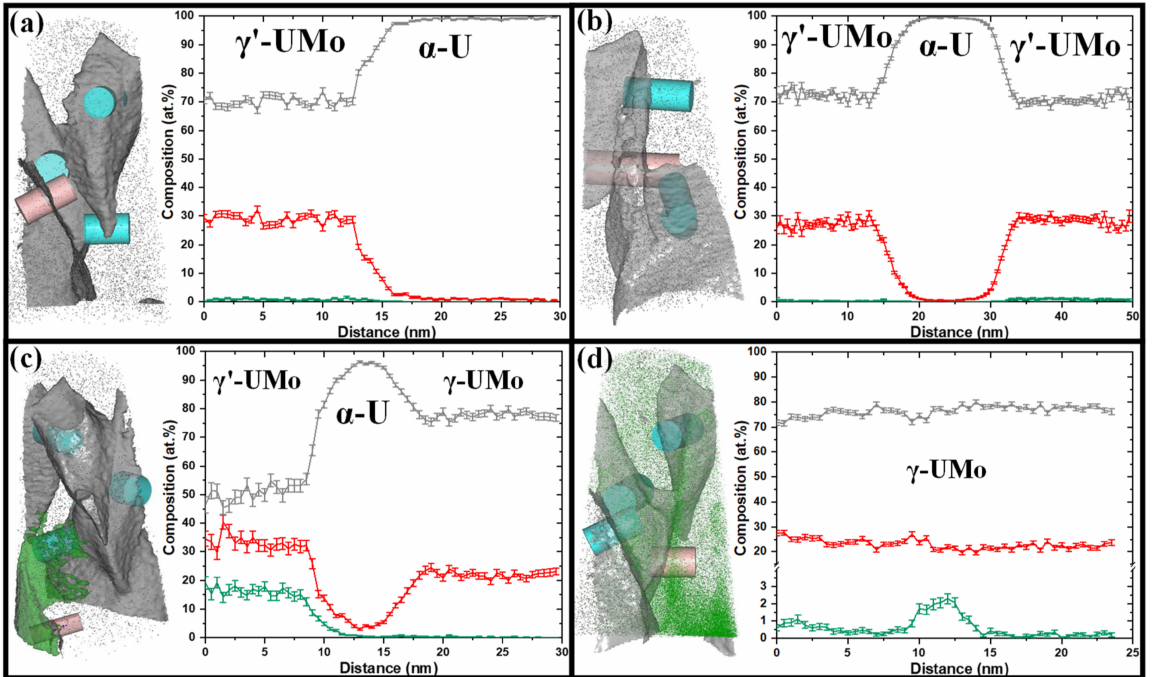
Figure 4. 1D profile taken across different features observed in a single tip from corresponding cylinder. ( a ) Mo-enriched U-Mo and α -U ( b ) and α -U sandwiched between Mo-enriched γ -U-Mo. ( c ) γ ’-U 2 Mo, α -U, and Mo-enriched γ -U-Mo, and ( d ) across the grain boundary, Mo-enriched γ -U-Mo phase. (grey: U, red: Mo, green: